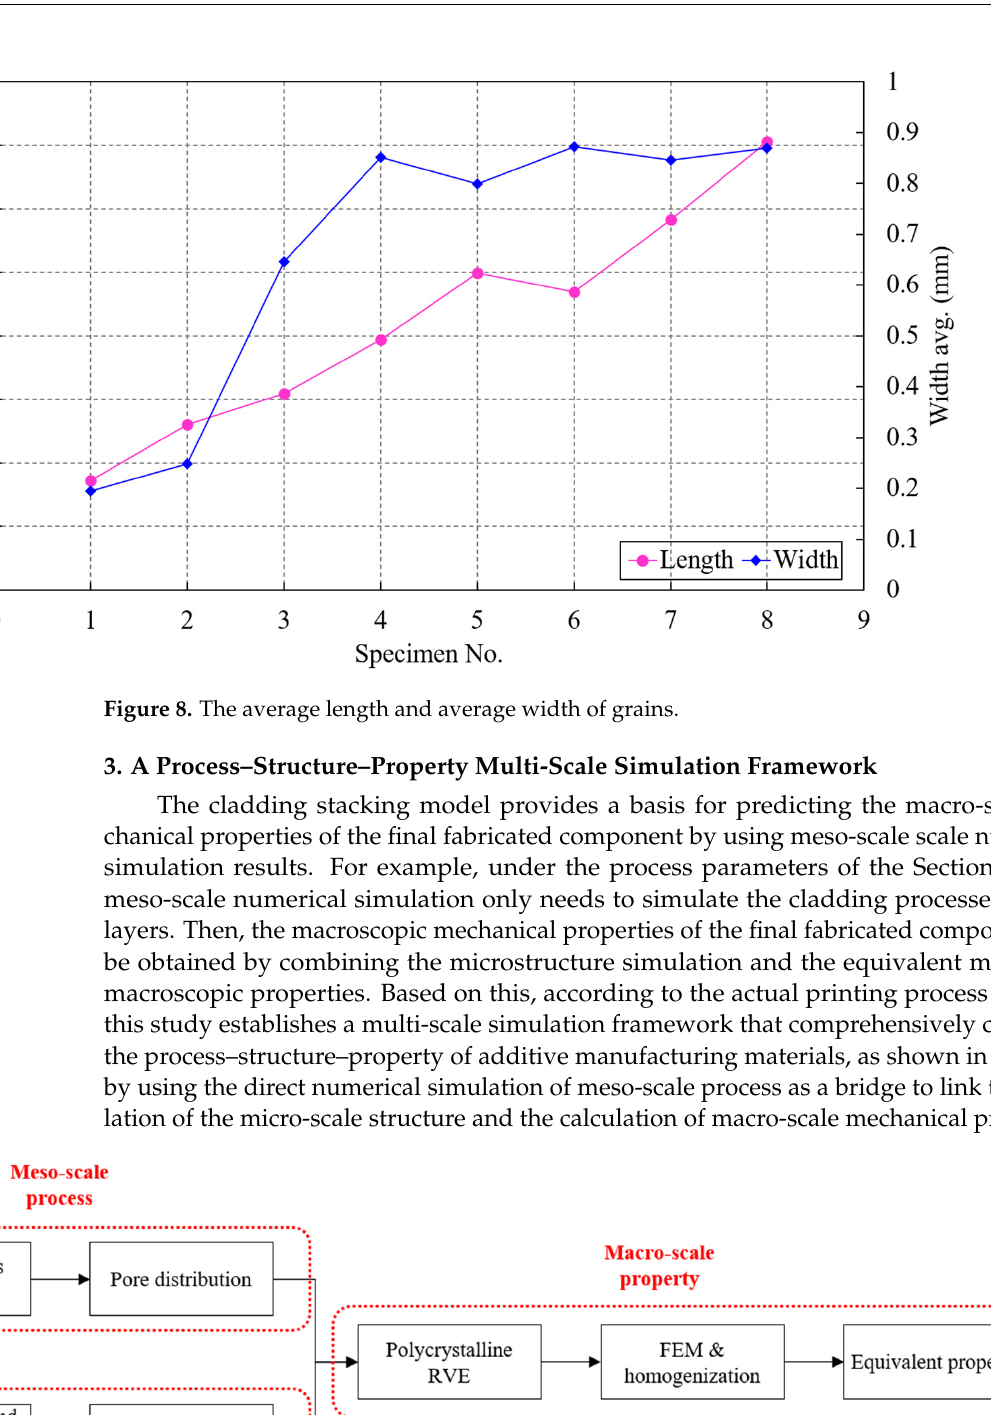
Figure 7. The range of the heat ‐ affected zone under the given process parameters.